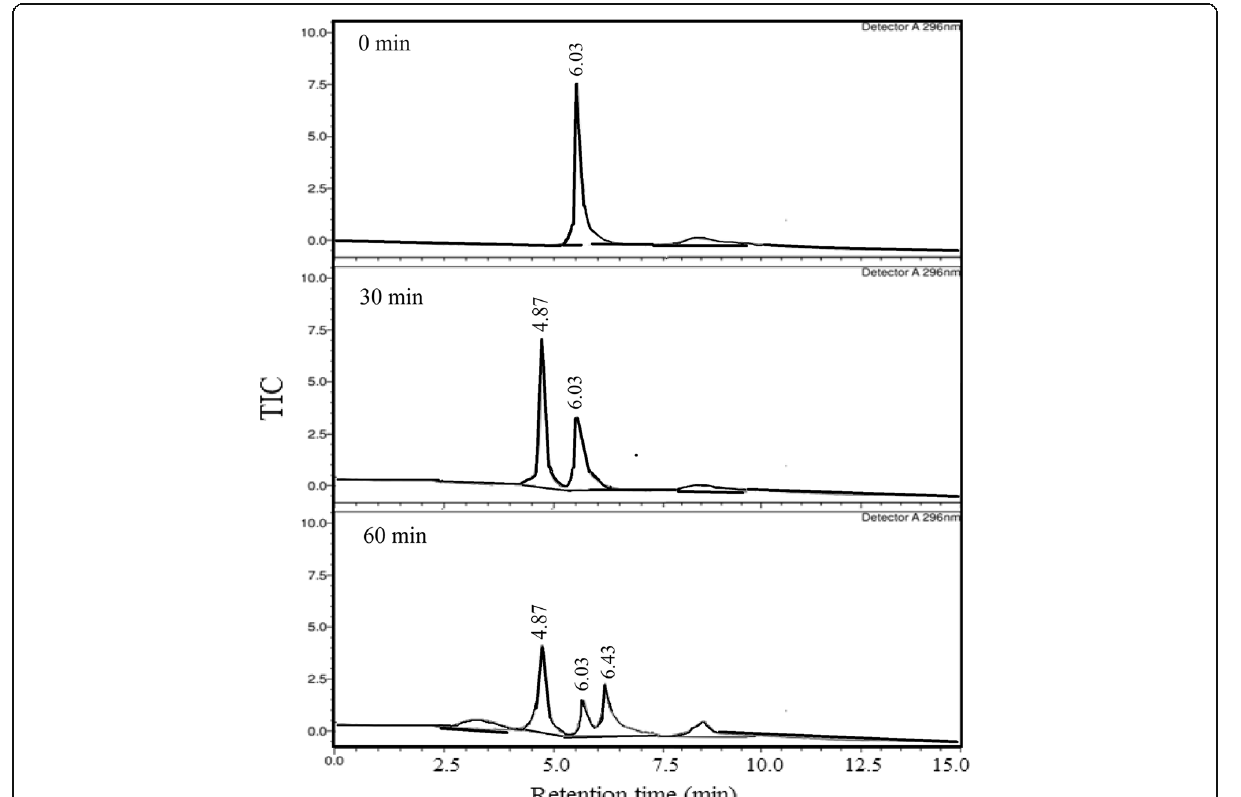
Fig. 8 Chromatogram from HPLC analysis of MV photooxidation treatment [Initial MV concentration= 25 mg L − 1 , H 2 O 2 = 10 − 4 M, catalyst dosage= 0.25 g L − 1 ]